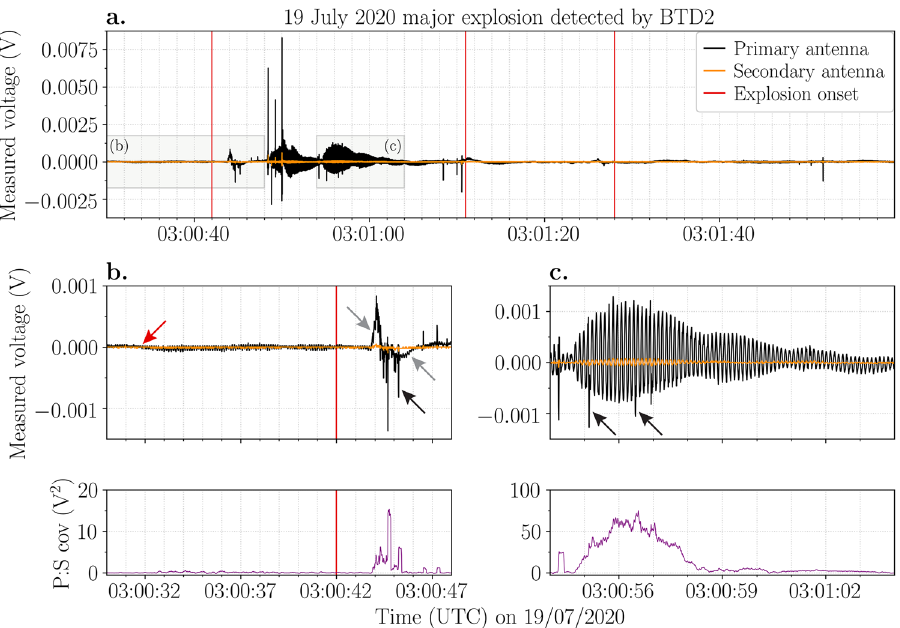
Figure 3. Voltage (V) measured by the primary (black line) and secondary (orange line) antennas of BTD2 during the 19 July 2020 major explosion. ( a ) Electrical signal detected during three separate explosions (red vertical lines) at 03:00:42 UTC, 03:01:11 UTC and 03:01:28 UTC. ( b ) An oscillating electrostatic signal starts approximately 10 s before the explosion onset (red arrow). Shortly after the onset, movement of charge (grey arrows) and electrical discharges (black arrows) were detected. ( c ) The amplitude of the oscillation is correlated to the magnitude of the charge variation. Electrical discharges are superimposed on the oscillations (black arrows). The corresponding covariance (V 2 ) between the primary and secondary signals is shown below for panels ( b ) and ( c ).